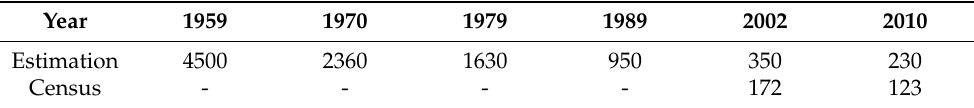
Table 1. Seto population of Pskov Oblast according to the estimation by Manakov